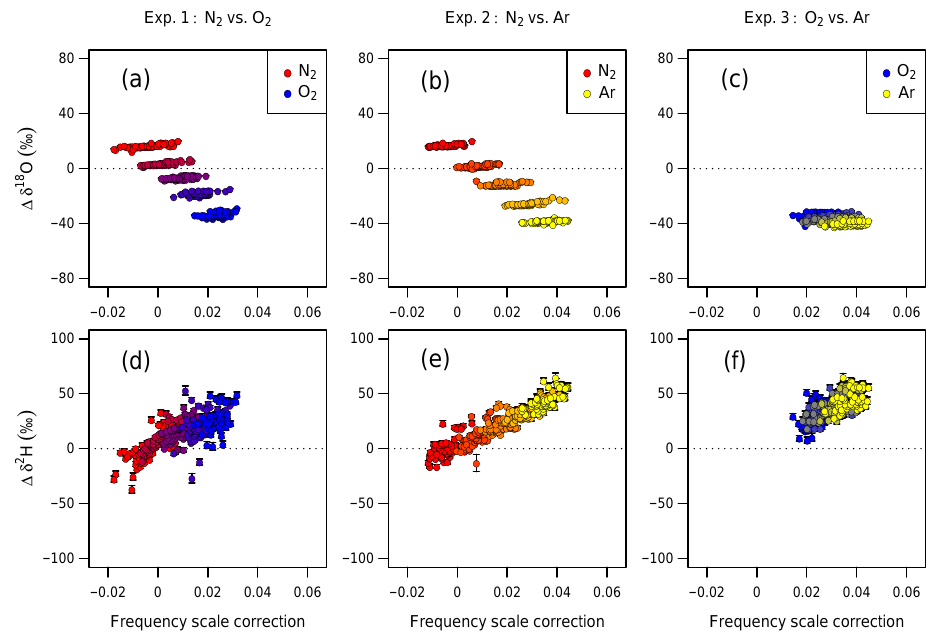
Figure 7. Relationship between the frequency scale correction, (cid:49)δ 18 O, and (cid:49)δ 2 H values. For each panel, n = 330 measurements of four liquid standards across a range of injection volumes (i.e., 400–2400nL, in 11 steps of 200nL each). Points represent mean values ± SD for replicates of each standard at each injection volume. Table 4. Semi-mechanistic models of the composite sensitivity of δ 18 O and δ 2 H values to all of the binary mixtures of N 2 , O 2 , and Ar. For significant predictors, coefficient estimates are given for β 7 in Eq. (6); see text. Overall model fit is summarized with the residual standard error (RSE), adjusted R 2 , and P value.